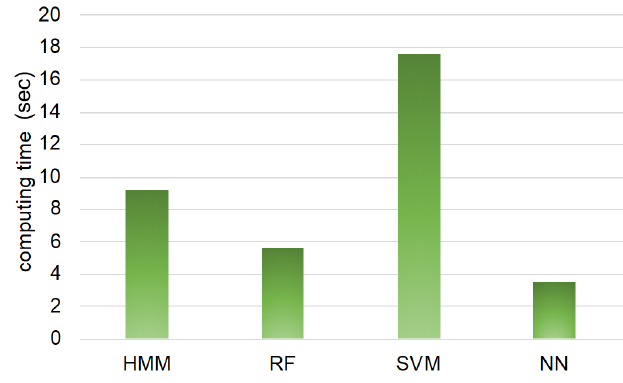
Figure 7. Computing time of each machine learning